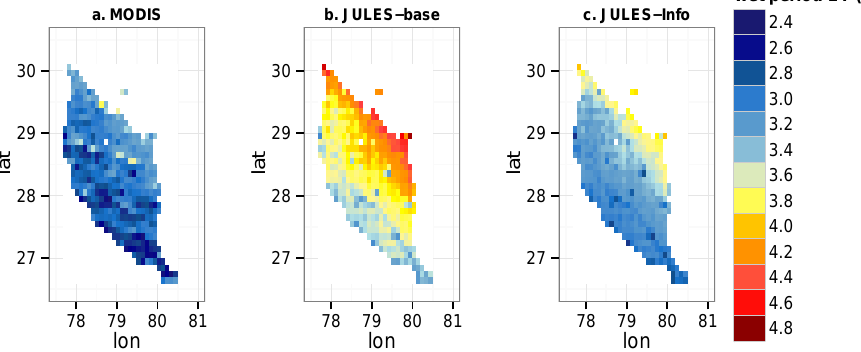
Figure 7. Spatial comparison of the modelled ET with the MODIS product, for agricultural areas, averaged over the wet (June–September) months of years 2000–2008.